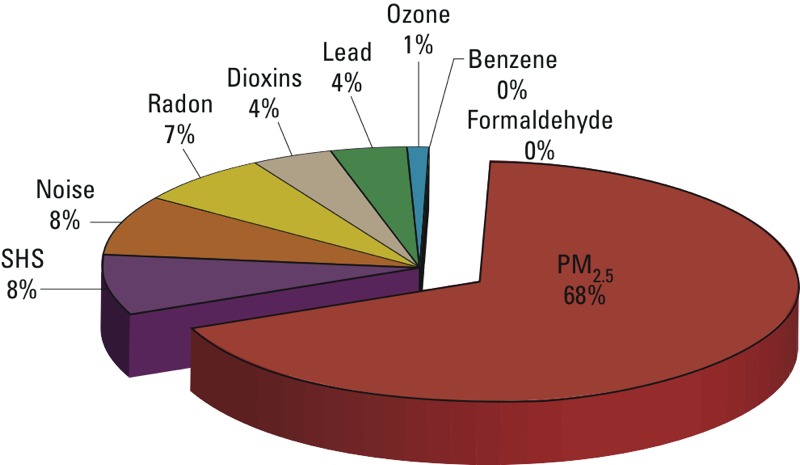
Relative contributions of the nine targeted risk factors to the estimated burden of disease attributed to these risk factors, averaged over the six participating countries. The figure is adapted from Hänninen and Knol (2011) with permission from the copyright holders.